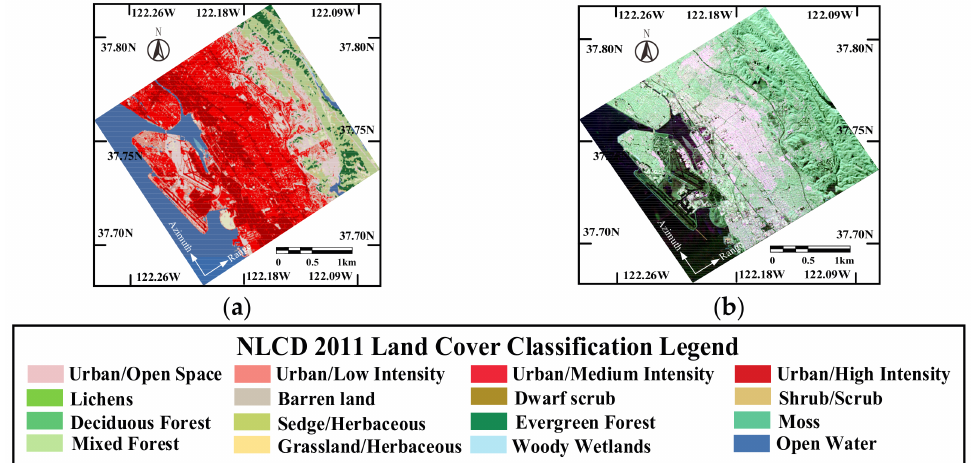
Figure 8. Second study area and UAVSAR data: ( a ) ground reference (NLCD 2011); and ( b ) Pauli-coded SAR image with